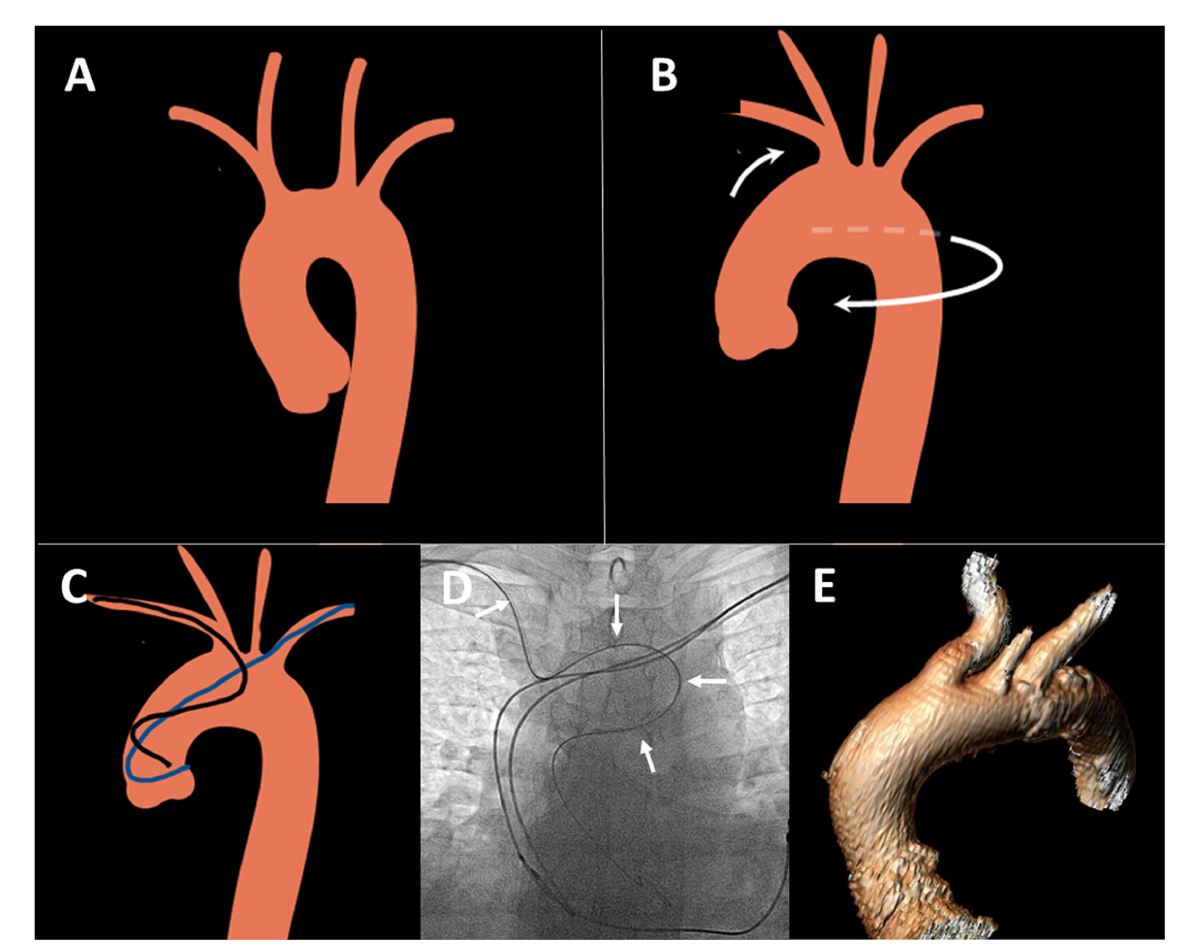
FIGURE1 Aortic unfolding and its consequences for transradial angiography. (A) Normal aortic arch anatomy: (B) Aortic unfolding leading to anti-clockwise rotation, elongation of aortic arch, posterior displacement and tortuosity of right radial and innominate artery (white arrows). (C) Unfavorable catheter position from right radial (black) compared to left radial (blue) access route in unfolded thoracic aorta. Figures created using smart.servier.com image bank. (D) Example of tortuous catheter route in unfolded aorta in elderly patient from right radial route, white arrows: EBU catheter. (E) 3D reconstruction of the unfolded aorta and posteriorly displaced innominate artery in a patient with severe aortic